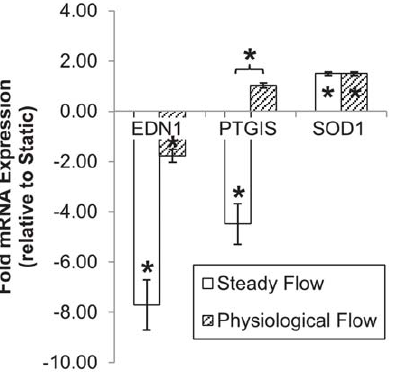
Figure 4. Cardio-protective gene expression in flow-condi- tioned endothelial cells. Shown is fold mRNA expression (with respect to static-cultured EC) of genes that promote or inhibit cardiovascular disease progression. Results are presented as mean 6- SEM. An embedded asterisk indicates a significant difference with respect to static controls; an asterisk over a bracket indicates a significant difference between flow groups. Abbreviations: EDN1 : endothelin-1; PTGIS : prostacyclin synthase; SOD1 : superoxide dismu- tase-1.